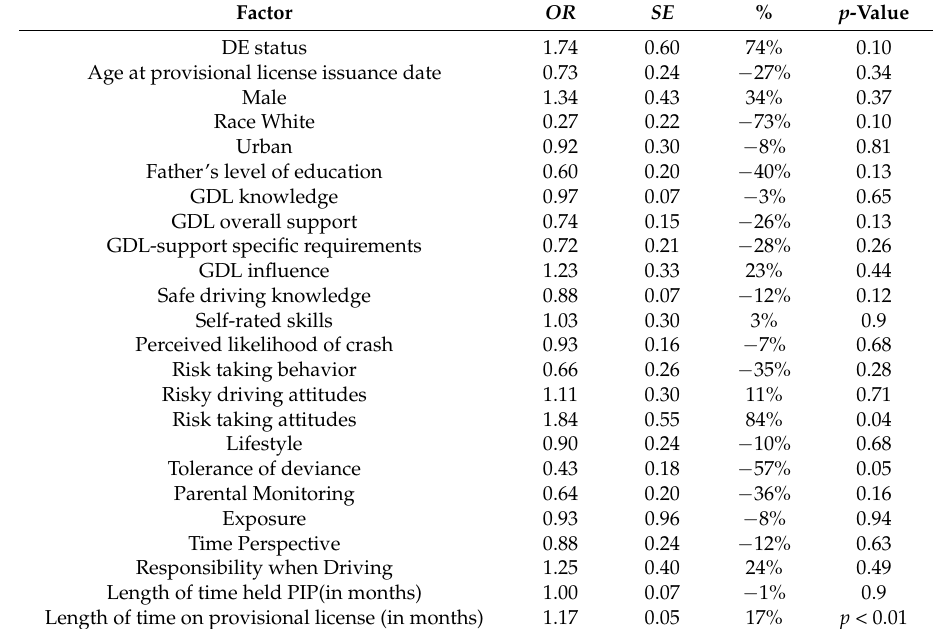
Table 1. Logistic regression with collision versus no collision as dependent variable. DE: driver education; GDL: Graduated Driver License; PIP: provisional instruction permit; OR : odds ratio; and SE : standard error.